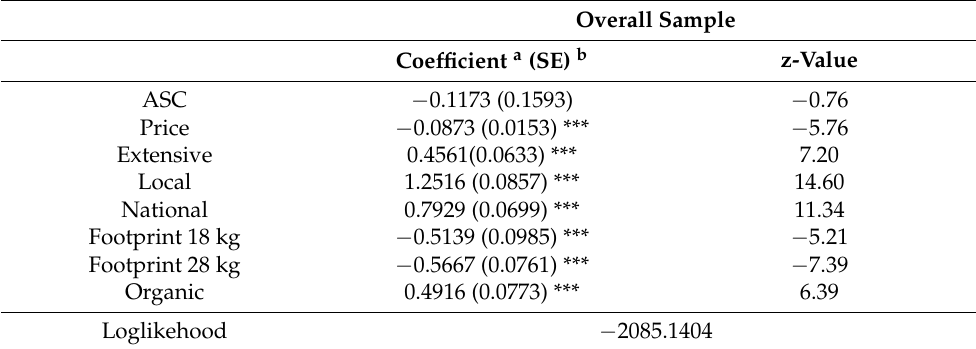
Table 3. Results from the logit model (Choice experiment) for the overall